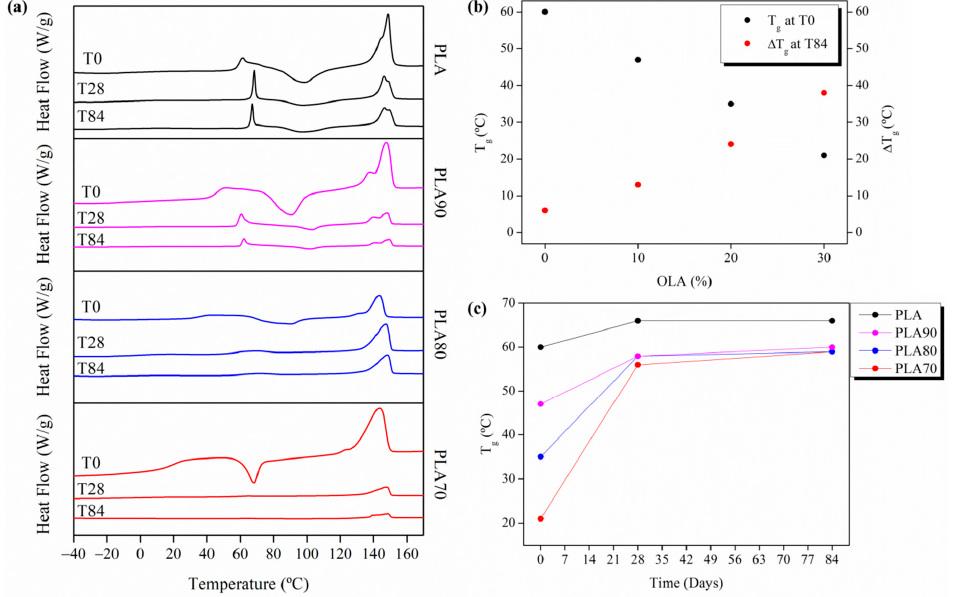
Figure 8. ( a ) DSC thermograms at T0, T28 and T84 of the different samples. ( b ) T g at T0 for the different samples and their variation at T84. ( c ) The evolution of the T g for neat PLA and each of the PLA:OLA electrospun samples after 0, 28 and 84 days of immersion in PBS. Table 4. Results of XRD analysis for neat PLA and each of the PLA:OLA electrospun samples for T0 and T84.